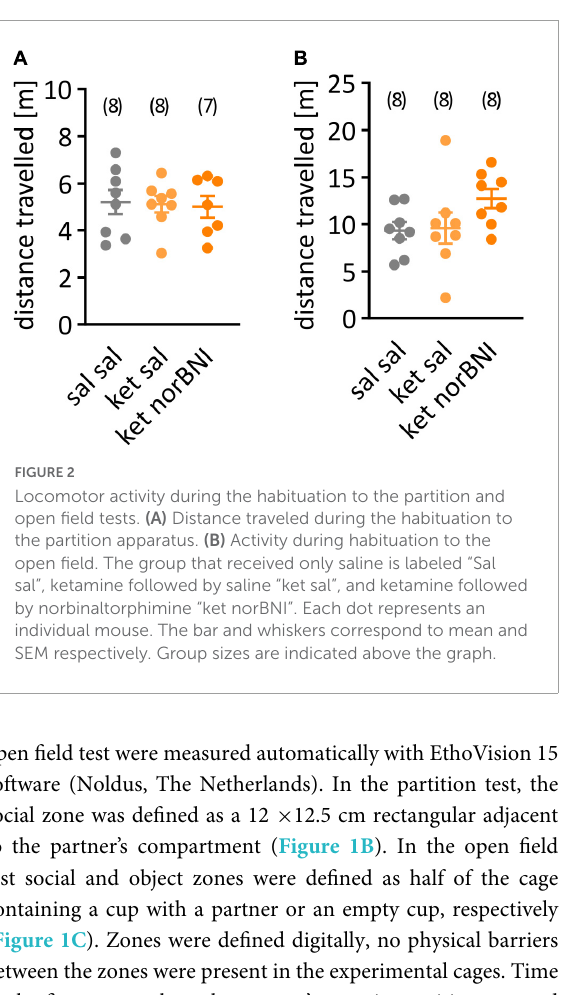
open field test were measured automatically with EthoVision 15 software (Noldus, The Netherlands). In the partition test, the social zone was defined as a 12 × 12.5 cm rectangular adjacent to the partner’s compartment ( Figure 1B ). In the open field test social and object zones were defined as half of the cage containing a cup with a partner or an empty cup, respectively ( Figure 1C ). Zones were defined digitally, no physical barriers between the zones were present in the experimental cages. Time